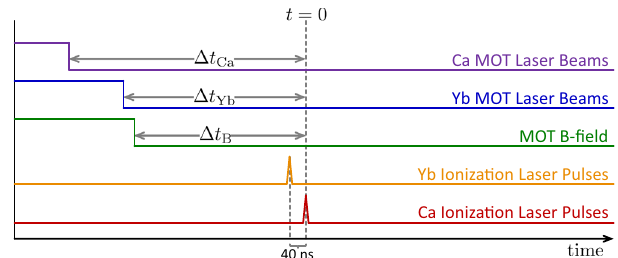
Fig. 6 Timing diagram for density selection and plasma creation. A step up indicates turning on and a step down indicates turning off the indicated quantity. The Ca and Yb neutral atom clouds are expanded for Δ t Ca and Δ t Yb to obtain the desired densities, typical expansion times range between 0.5 and 2 ms. The pulse delay for the ionization pulses is 40 ns to eliminate cross ionization to preserve the known electron temperature of the plasma. Otherwise, the Ca + ionization pulses would also ionize the Yb atoms and produce a very high electron temperature. Due to the large ion mass, the Yb + plasma does not expand on this 40 ns time scale. Data plotted in previous fi gures also have this 40 ns delay. Its in fl uence is imperceptible in the data. The MOT magnetic fi eld is turned off Δ t B = 500 μ s prior to